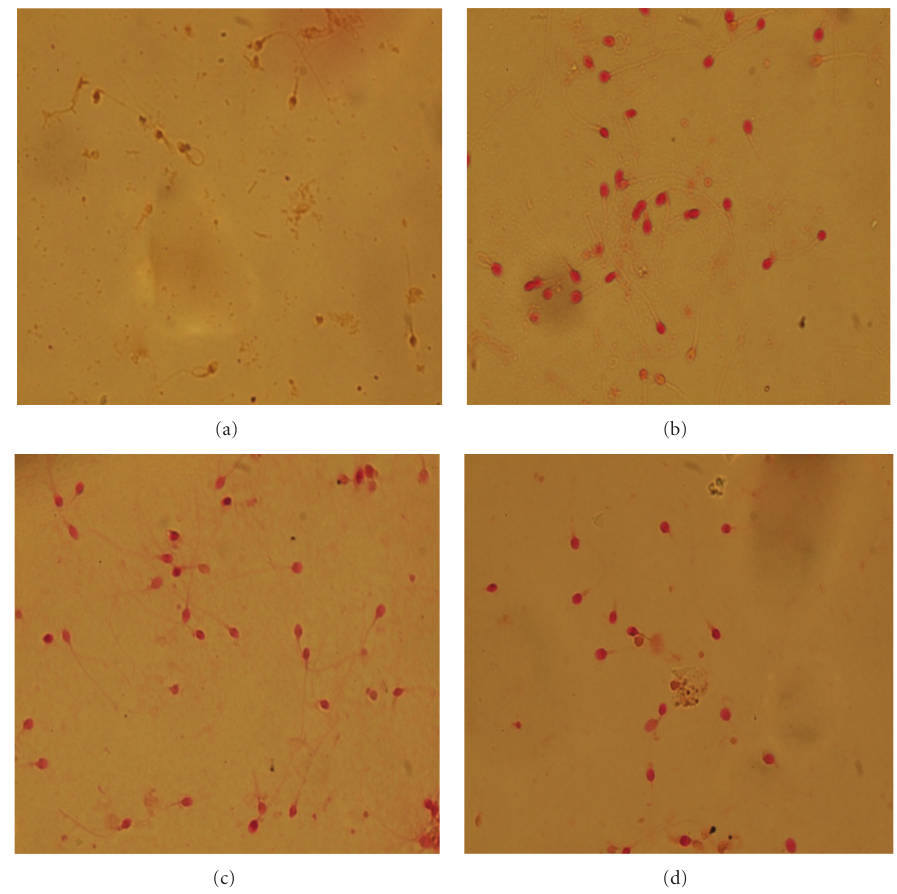
Figure 1: Red or pink staining of the acrosomal region indicated intact acrosomes, whereas white, brown, or yellowish acrosomes were interpreted as acrosome reacted. Induced sperm acrosome reaction on treatment with calcium ionophore (1000x)-positive control (a). E ff ect of SIF on calcium ionophore induced sperm acrosome reaction (1000x) (b). Sperm acrosome reaction on treatment with DMSO (1000x)-negative control (c). E ff ect of SIF on sperm acrosome reaction in DMSO-treated sample (1000x) (d).